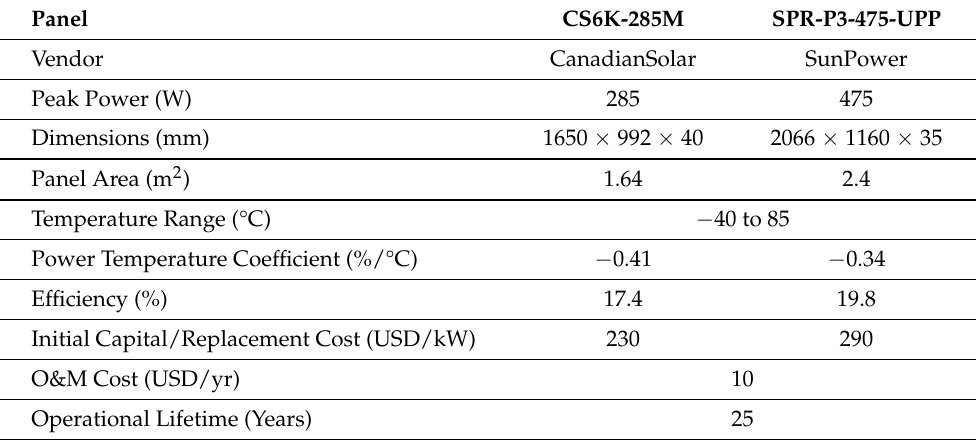
Table 5. PV panels and their specifications.